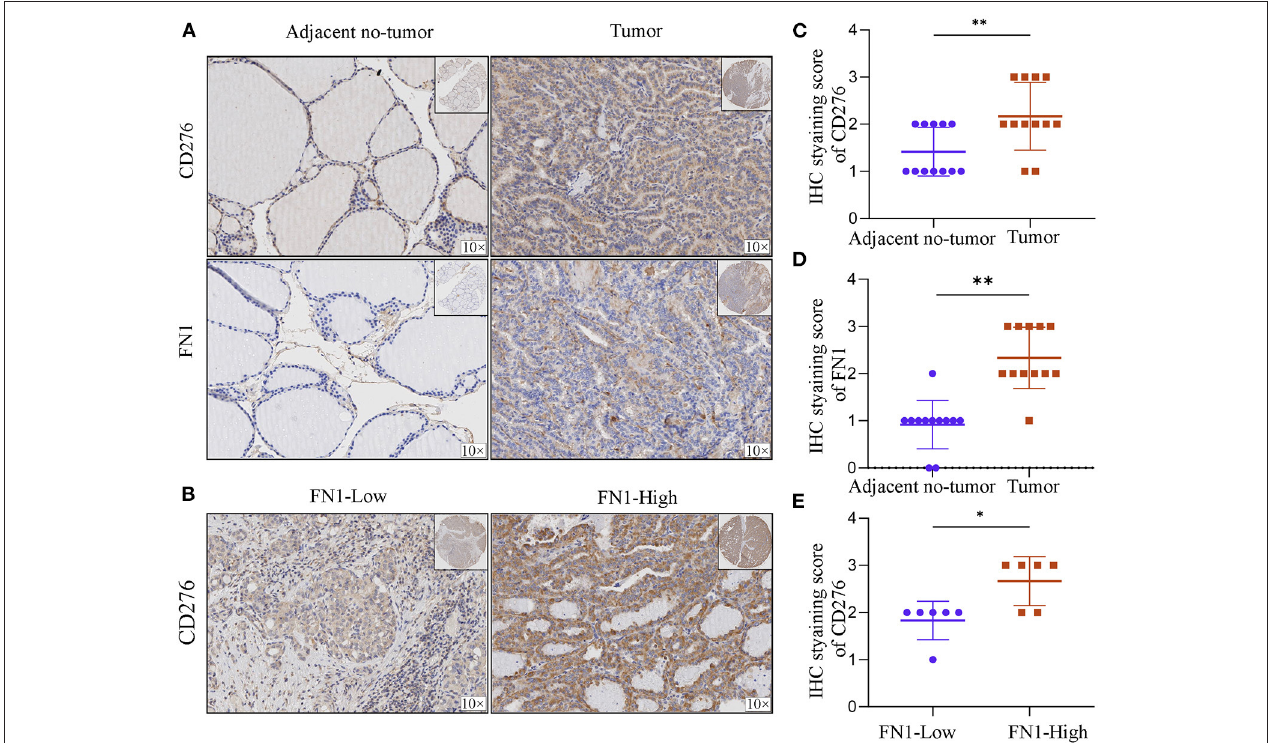
FIGURE 7 | The correlation between FN1 and CD276 in THCA. (A) Representative IHC staining of CD276 and FN1 in tumors and adjacent no-tumor tissues from THCA patients. (B) Representative IHC staining of CD276 in tumor tissues from FN1-high and low patient groups. IHC score of CD276 (C) and FN1 (D) in adjacent no-tumor tissues and tumor tissues form patients with THCA. (E) IHC score of CD276 in tumor tissues from FN1-high and low patient groups, * p < 0.05, ** P < 0.01.